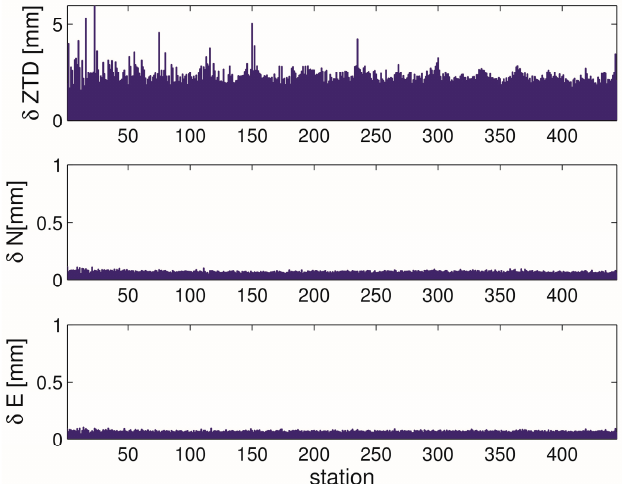
Figure 1. Tropospheric parameter differences between the NWM and PPP method. The top panel shows the station specific root-mean-square deviation for the ZTD. The middle and lower panel shows the station specific root-mean-square deviation for the north- and east-gradient coefficients, respectively. We consider four epochs per day (0, 6, 12, 18 UTC) and a period of two months (June and July, 2017).